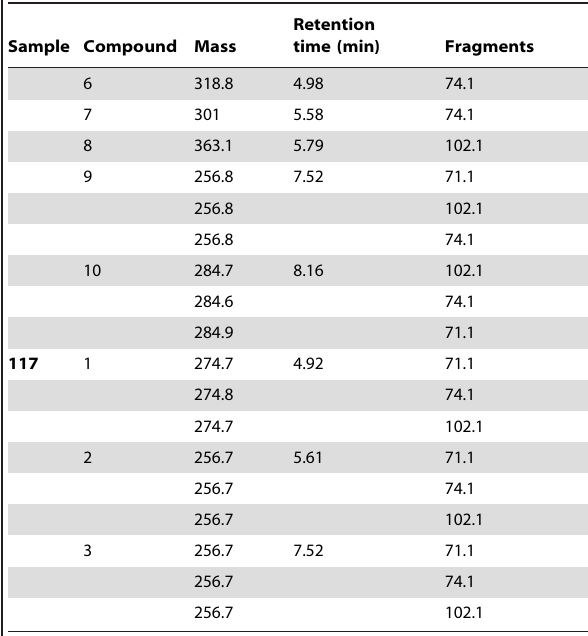
Table 1. Observed precursors displaying fragments corresponding to 102.1, 74.1 and